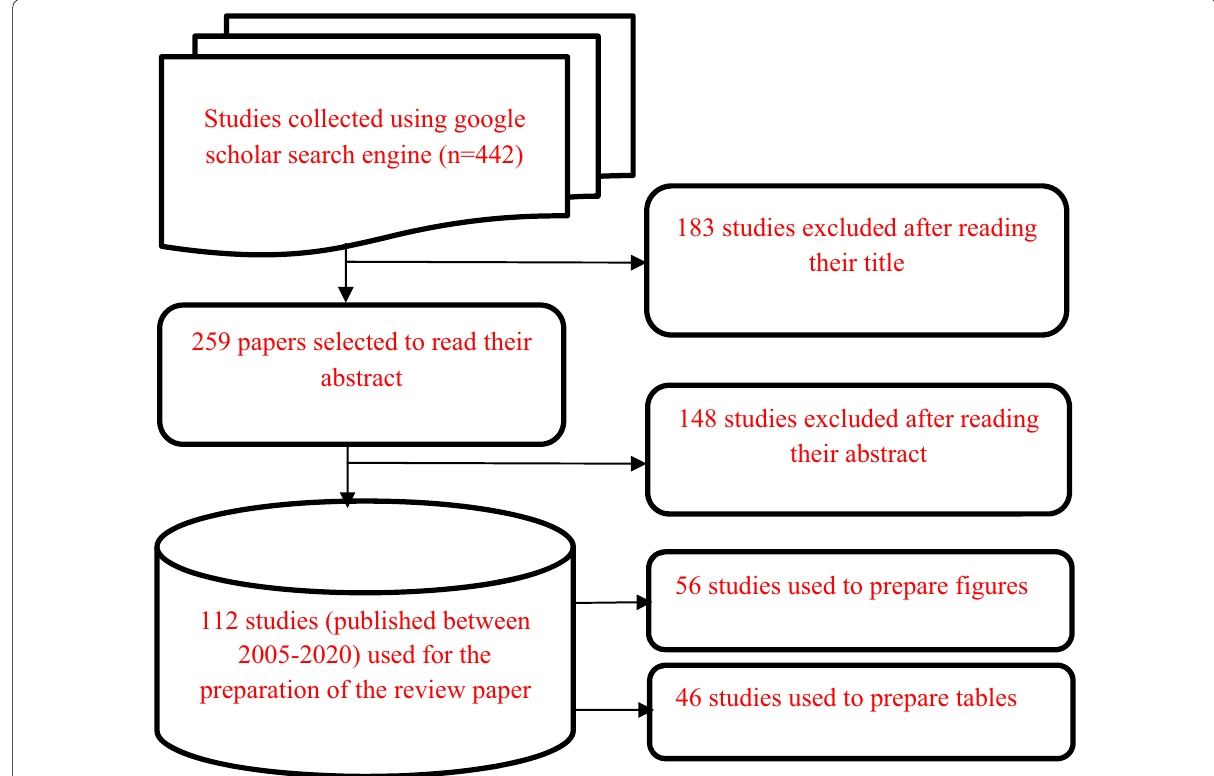
Fig. 1 Selection process of articles used for the review